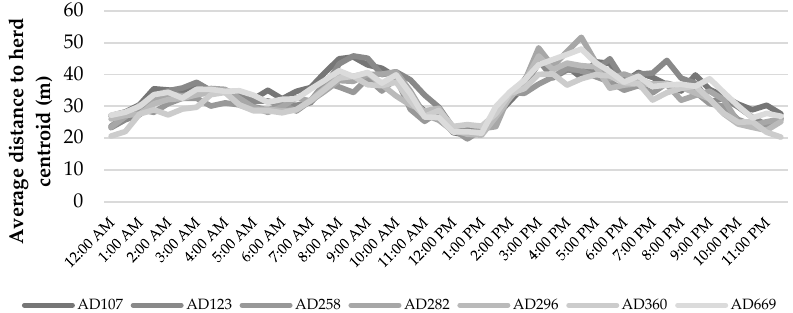
Figure 7. Individual variability of cattle behavior in relation to the herd.